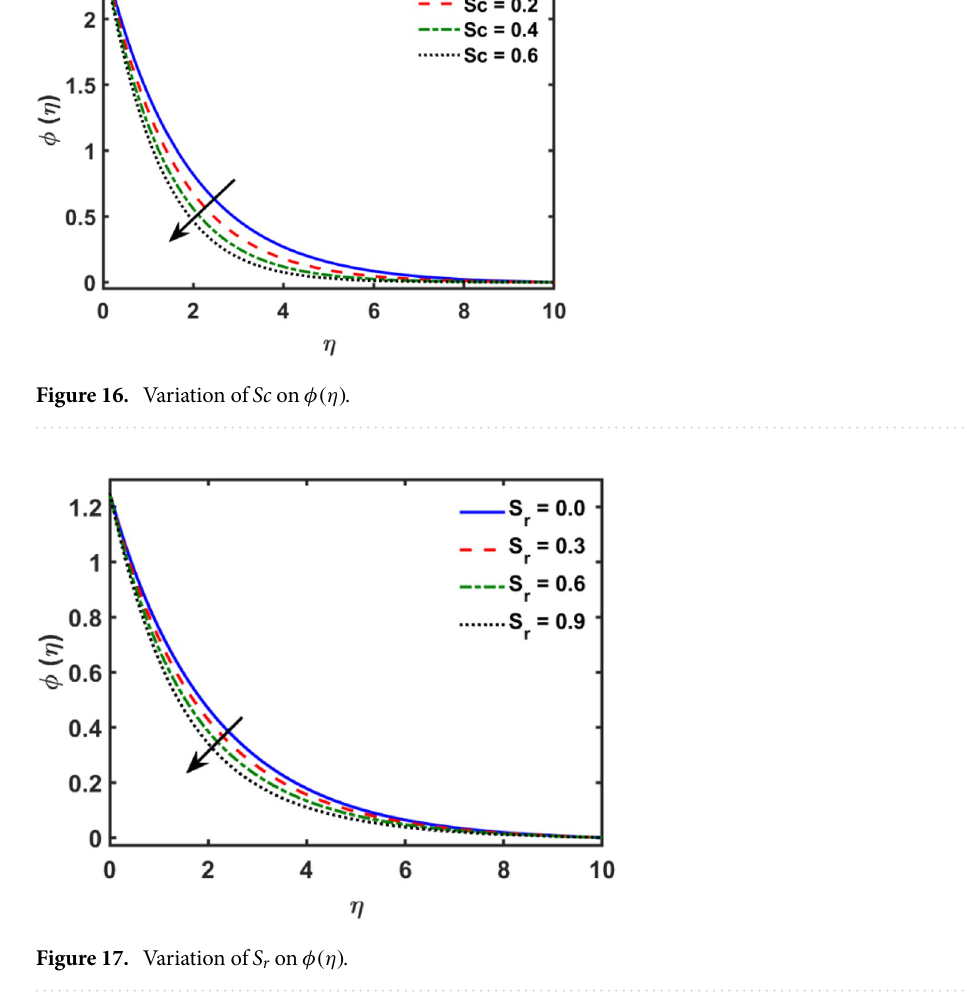
in Fig. 3. The curves of fluid velocity enhanced due to increasing the values of (cid:31) . Velocity slip is a fluid-boundary interaction in physics. If the velocity slip increased, the fluid velocity profile would eventually become increas- ing. Second order slip (cid:31) 1 influence on fluid velocity presented in Fig. 4. Fluid velocity curves revealed declining behavior due to improving the (cid:31) 1 . The impact of M on fluid velocity presented in Fig. 5. The velocity of fluid declined by boosting values of M . In fact, increasing magnetic field value increases the external magnetic field. This increase in the external magnetic field causes a wall parallel Lorentz force, which slows the expansion of the momentum boundary layer. When looking at the figure closely, it can be seen that the velocity suddenly declined towards the plate as the magnetic field increases. The variation of S r and fluid velocity presented in Fig. 6. Increasing of S r which lessened the curves of fluid velocity. Due to crass diffusion impacts, the S r (thermo diffusion) increasing which resist to fluid velocity as well as fluid velocity declined. Figures 7, 8, 9, 10, 11 and 12 depicted the impact of γ 1 , K 1 , N B , Rd , N T and D f on the fluid temperature. Figure 7 depicted the variation of γ 1 and temperature function. Temperature curves declined by improving values of γ 1 . Figure 8 depicted the variation of K 1 and temperature function. Temperature curves declined by improving values of K 1 . The thermal thick- ness reduced when improved the values of K 1 . Figure 9 depicted the N B on temperature function. Temperature function curved boosted due to boosting values of N B . Physically, the Brownian motion developed the kinetic energy as well as Brownian motion increased which increased the kinetic energy ultimately temperature of fluid increased. Impact of Rd o fluid temperature depicted in Fig. 10. Values of Rd and fluid temperature found to be same behavior of increasing found. Physically, radiation increasing means energy increased as well as tem- perature of fluid increased. Figure 11 revealed the impact of N T on temperature function. Temperature function increased due to improving values of N T . As the values of N T increased which enhanced the temperature due to N T has high gradient temperature. The variation of D f and temperature function depicted in Fig. 12. The values of D f and fluid temperature found to be same behavior of increasing. Thermal thickness increased as well as D f (diffusion-thermo) increased. The impact of β , D f , (cid:31) 2 , Sc and S r on concentration function which presented in Figs. 13, 14, 15, 16 and 17. Impact of β on fluid concentration function presented in Fig. 13. Curves of fluid con- centration declined due to boosting values of β . Variation of D f on the fluid concentration presented in Fig. 14.